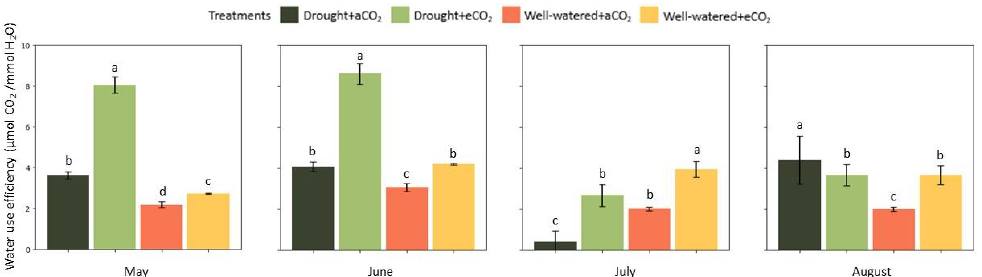
Figure 2. Effect of elevated CO 2 (950 ppm) and cyclic drought stress in the mean value (± confidential level of 95%) of Eucalyptus grandis water use efficiency (WUE). Different small letters indicate statistical significance between the means ( p < 0.05).